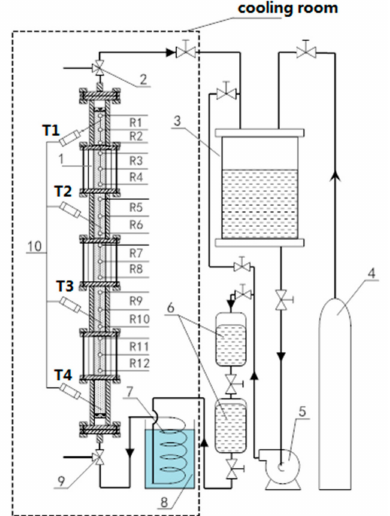
Figure 1. One-dimensional visual hydrate simulator. 1: sapphire tube; 2, 9: pressure transducer; 3, 6: interface chamber; 4: gas-supply cylinder; 5: constant flow pump; 7: coiler; 8: warm bath; 10: resistance temperature detectors.